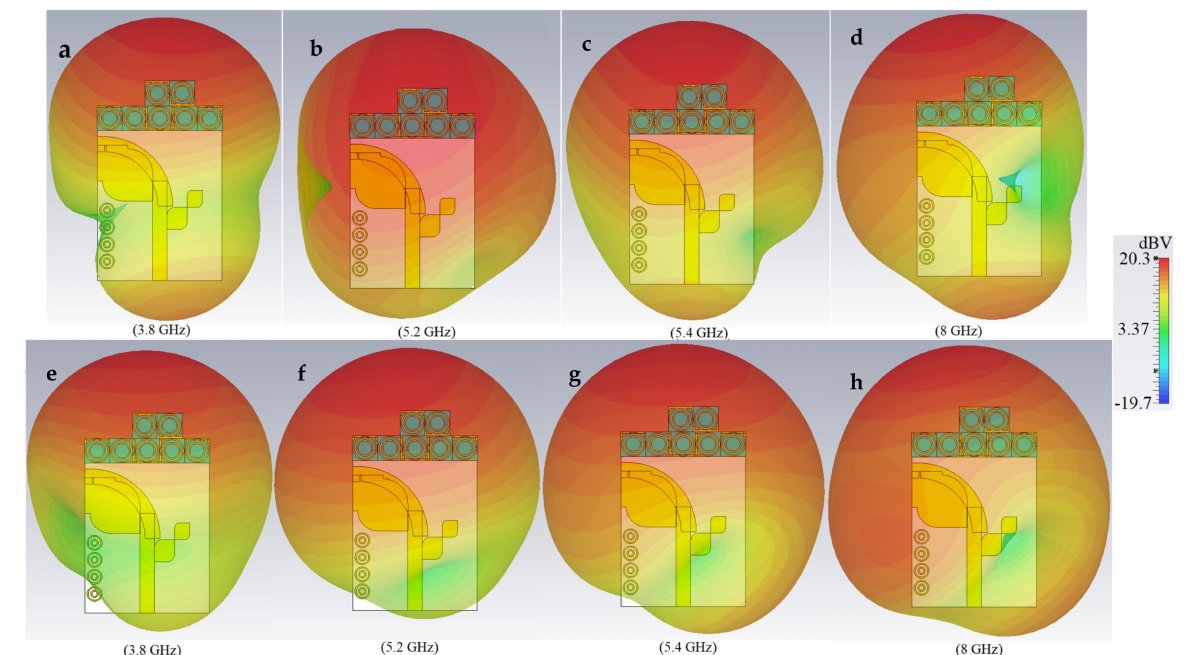
Figure 14. The 3D E-pattern of the proposed antenna integrated with MTM elements ( a ), and ( e ) at 3.8 GHz; ( b ) and ( f ) at 5.2 GHz; ( c ) and ( g ) at 5.4 GHz; and ( d ) and ( h ) at 8.0 GHz (red color is maximum and blue is the minimum).